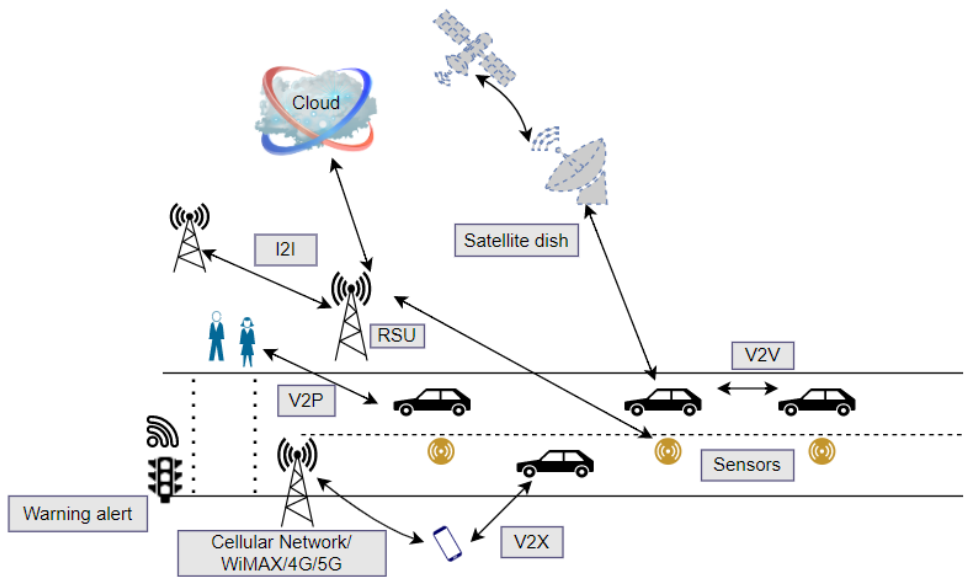
Figure 1. VANET in Smart